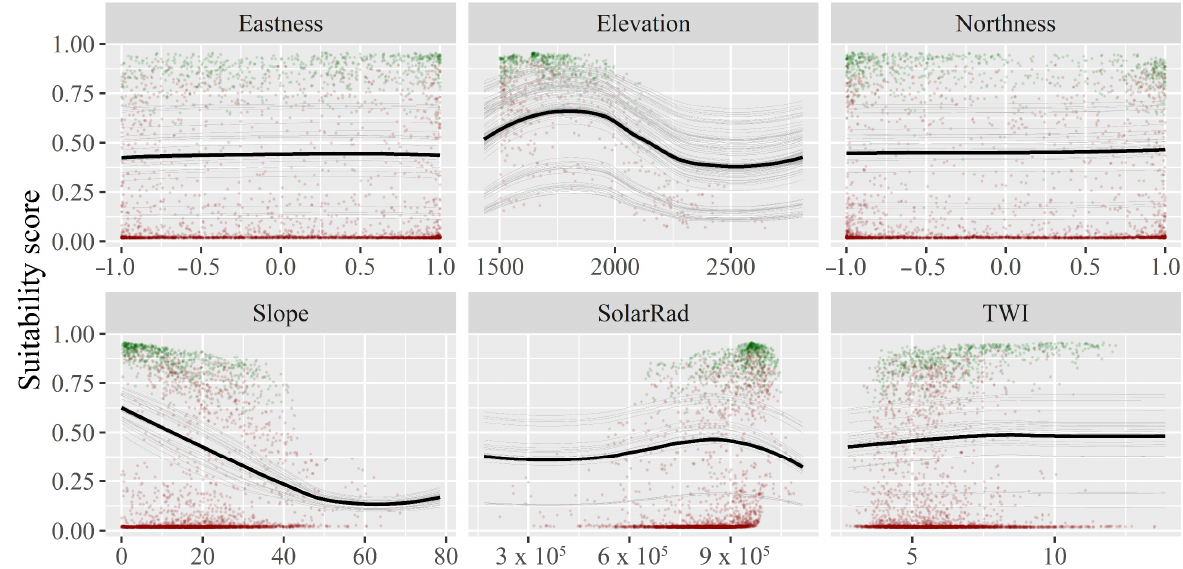
Figure 5. The inflated response curve of topographic variables for Brachypodium genuense in the study area. The green line is the average of the 100 inflates curve randomly selected. The presences (green dots) and pseudo-absences (red dots) used to calibrate the model. x -axis: Northness = cosine (aspect) and Eastness = sine (aspect); Elevation = m a.s.l.; Slope = degrees; Solar Radiation = WH/m 2 ; Topographic Wet Index (TWI), high values indicate humid areas and low values indicates dry areas.